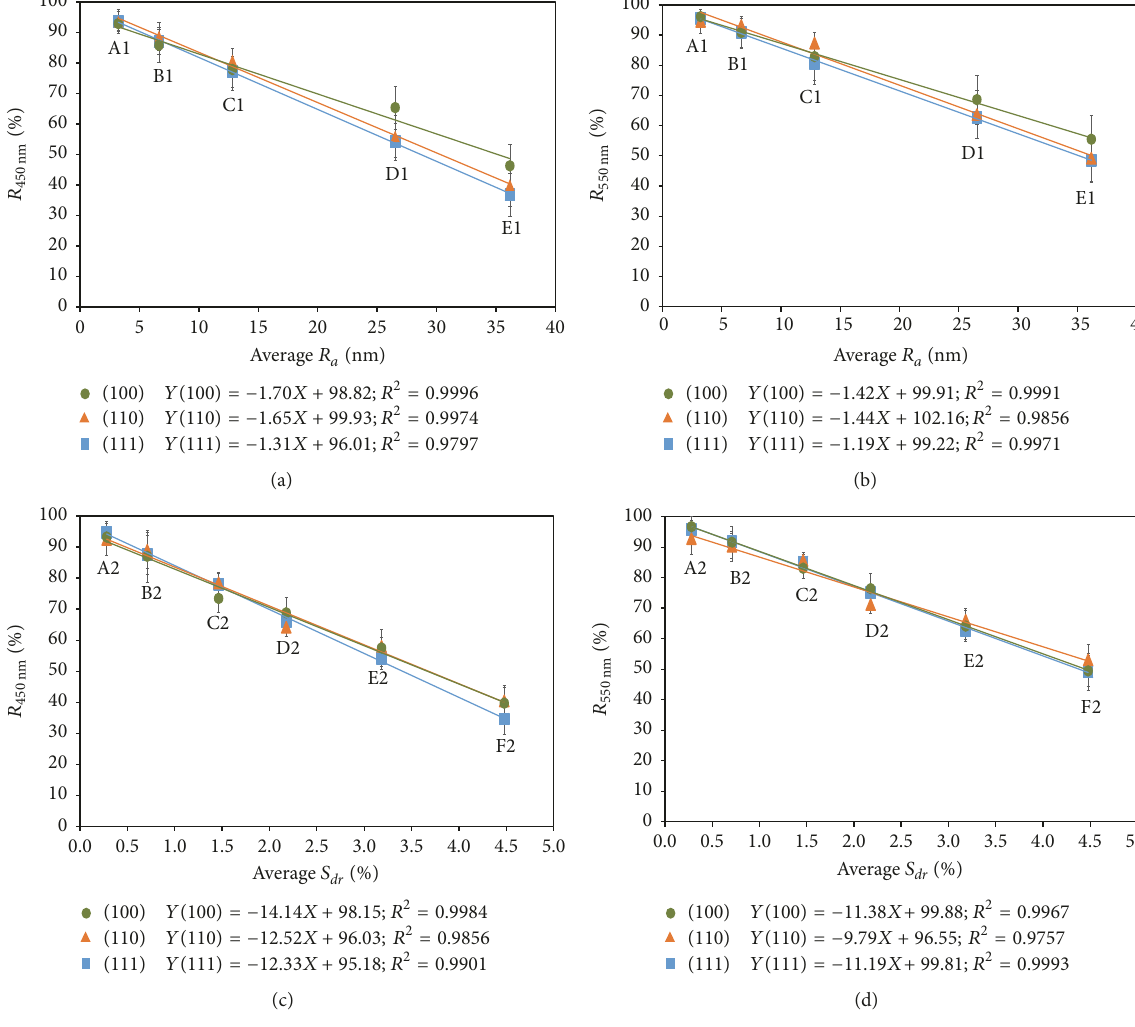
Figure 3: The dependence of specular reflectance on (a-b) the average 𝑅 𝑎 for Groups A1–E1; (c-d) the average developed interfacial area ratio ( 𝑆 𝑑𝑟 ) values for Groups A2–F2 of Ag (100), Ag (110), and Ag (111) crystals at 𝜆 = 450 nm and 550 nm,